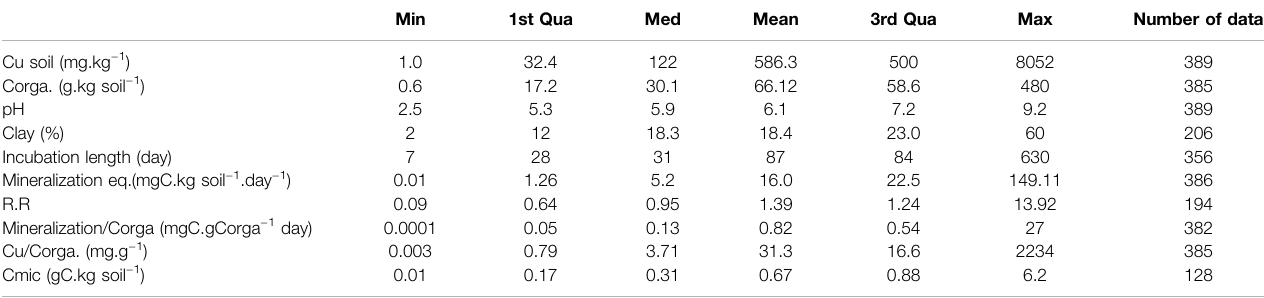
TABLE 1| Numberofcollecteddataafterthe fi nalselectionofthe46papers and theircorresponding rangesofvaluesgivenasminimal (Min),medium (Med),maximal(Max), 1 st and 3 rd quadrant (Qua) and mean (Mean) values. Corga is the soil organic carbon content, R.R is the Response Ratio calculated according to Eq. (1) , Cmic is the microbial C